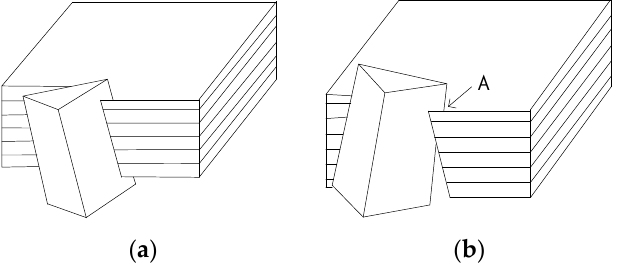
Figure 3. Analysis of milling process: ( a ) Cutting by left-leaning cutting edge; ( b ) Cutting by right-leaning cutting edge.